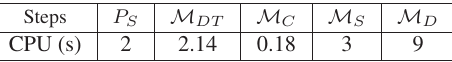
Table 2: Computation time for dataset Urban ♯ 2 illustrated in Fig-